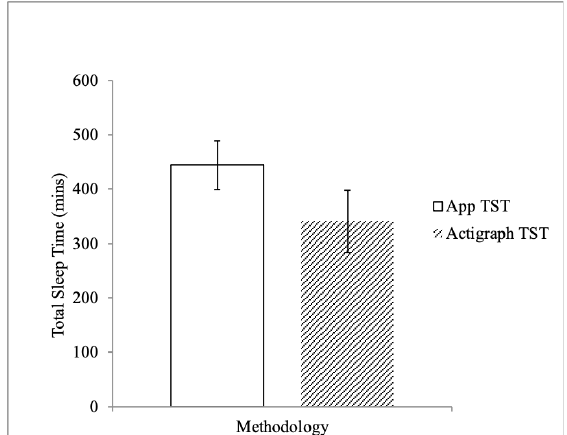
Figure 1. App vs. actigraph. Graph comparing TST in minutes as measured by the Sleep Time App (M = 444.3, SD = 44.52) to TST measured by actigraphy (M = 341.0, SD =